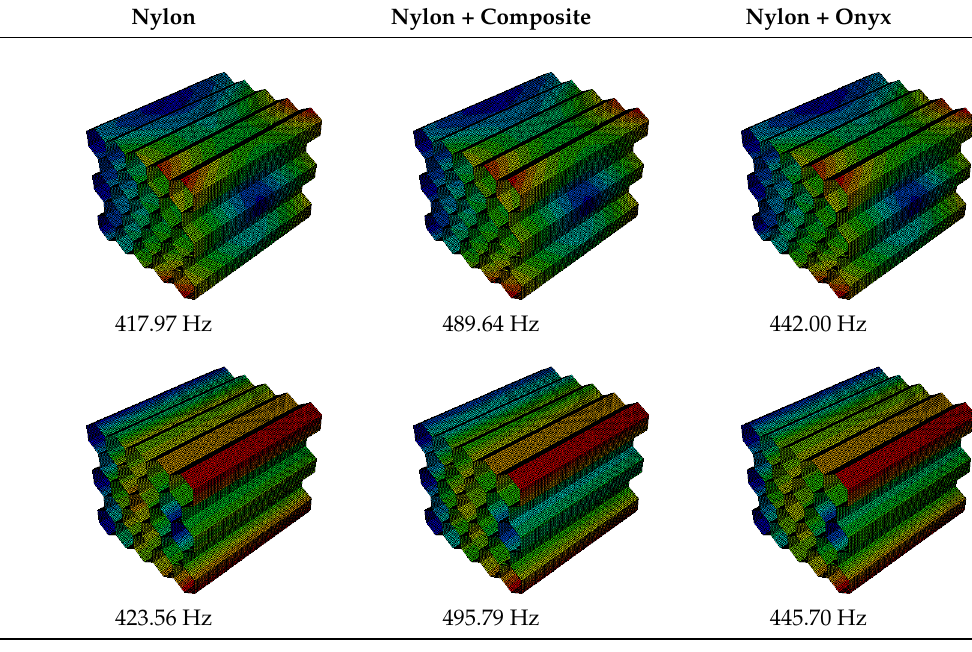
Table 8. Cont. Nylon Nylon + Composite Nylon + Onyx